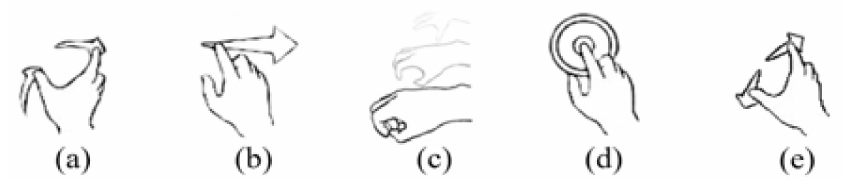
Figure 5. The types of standard actions for assembly: ( a ) rotating, ( b ) moving, ( c ) grasping and releasing, ( d ) pointing, and ( e )